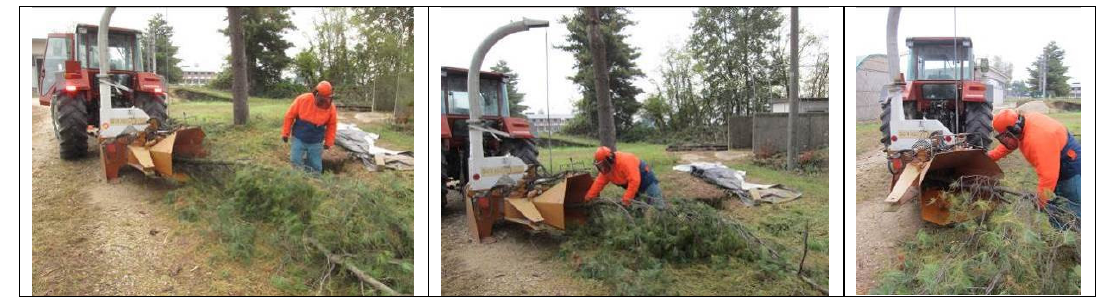
Figure 7. Images of the procedures followed during the wood speed test, operated with a 28 ‐ years ‐ old wood chipper.